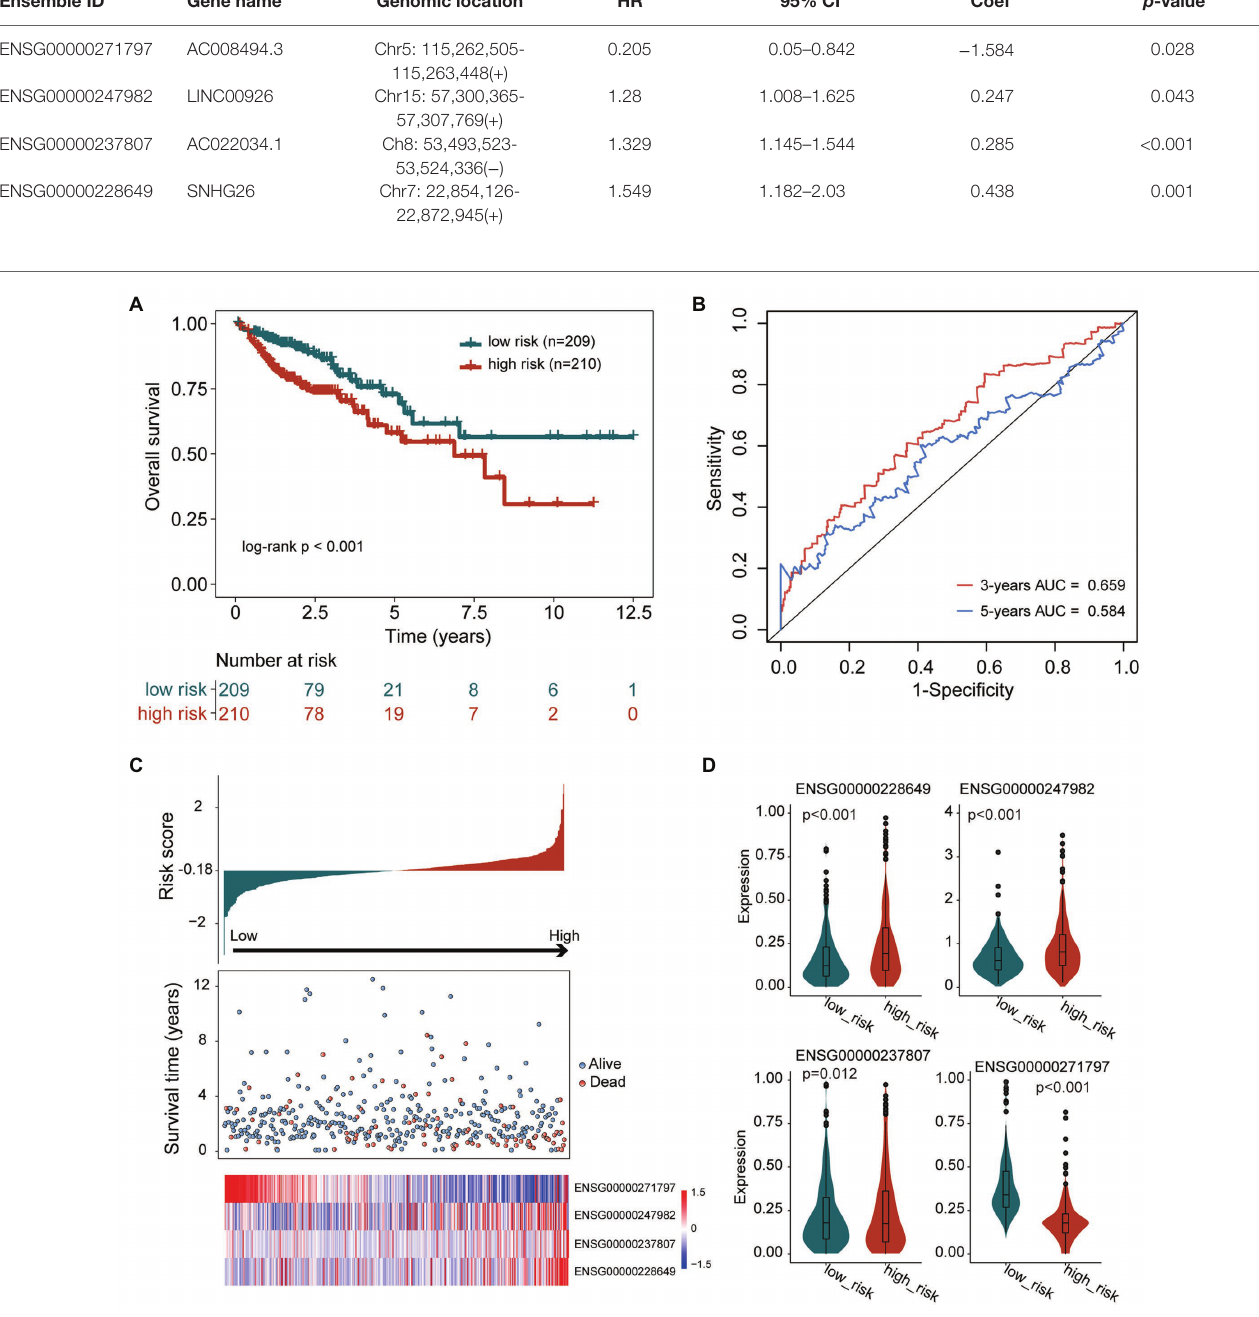
FIGURE 2 | Performance evaluation of the tumor immune infiltration-associated lncRNA signature (TIILncSig) for predicting overall survival in the TCGA cohort. (A) Kaplan-Meier survival curves of overall survival between high- and low-risk groups. (B) The time-dependent receiver operating characteristic (ROC) analysis of the sensitivity and specificity for survival prediction by the TIILncSig. (C) The risk score distribution, survival status, and expression pattern of the TIILncSig. (D) Boxplot representing expression differences of lncRNAs between high- and low-risk